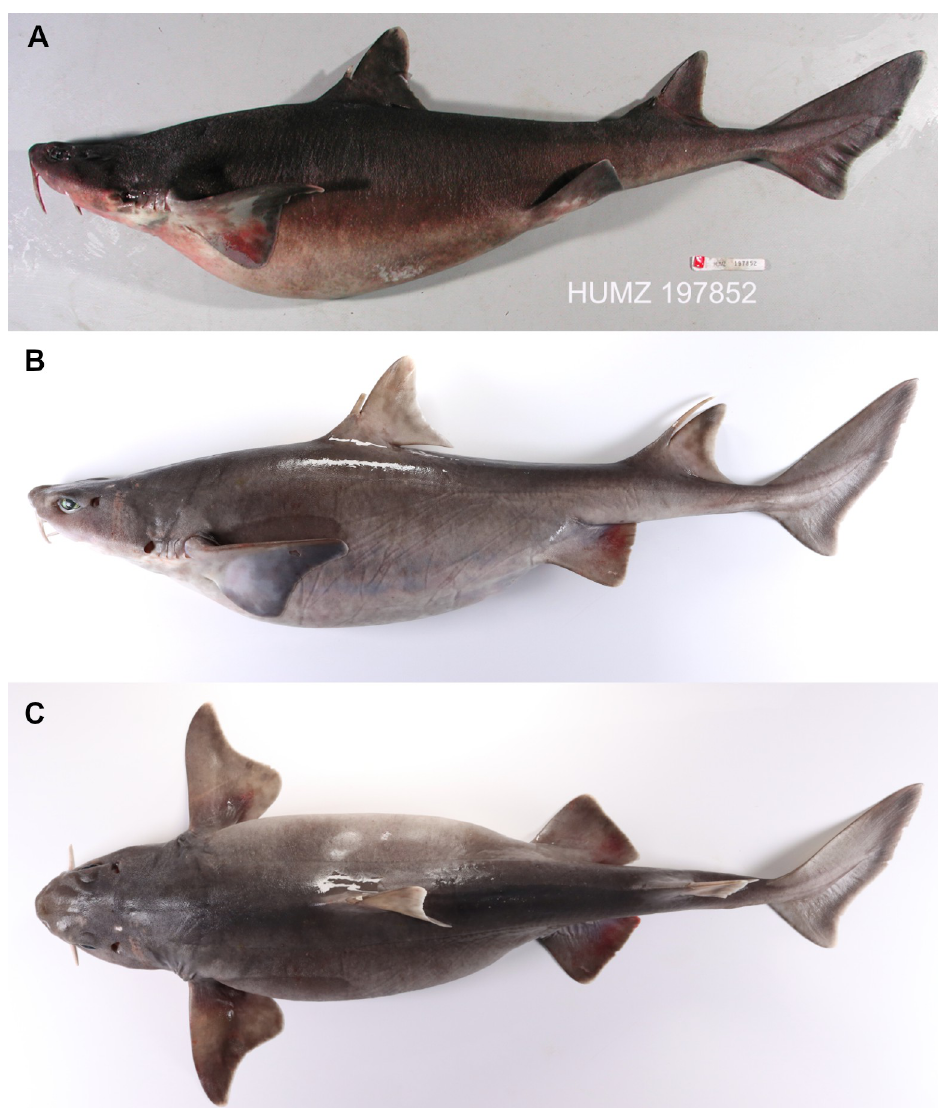
Fig 16. Cirrhigaleus barbifer in lateral (A,B) and dorsal (C) views. A: HUMZ 197852 (neotype of C . barbifer ), adult female, 870 mm TL; B,C: HUMZ 231872, adult female, 899 mm TL (photo credits: Fisheries Science Center, The Hokkaido University